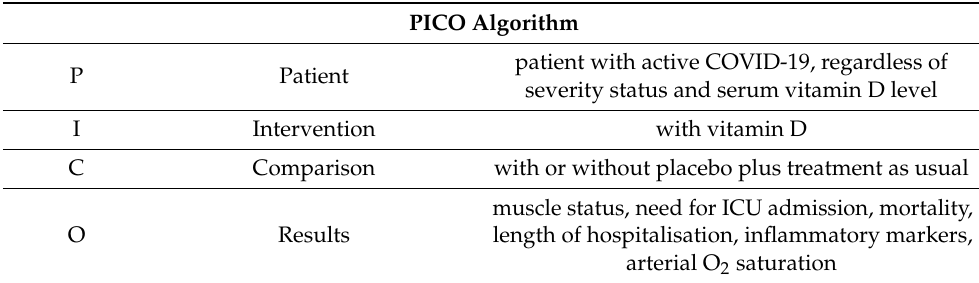
Table 1. Inclusion criteria based on PICO